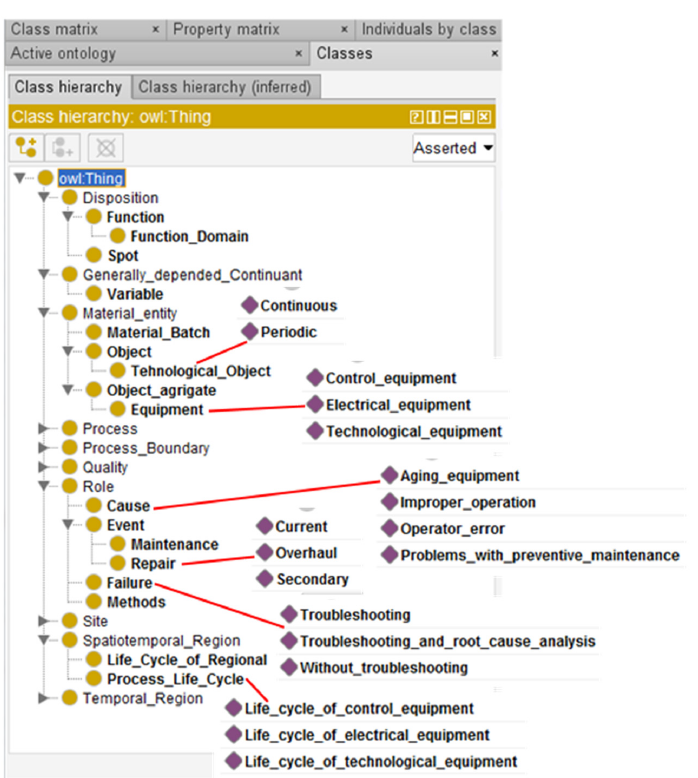
Figure 3. Core ontology class hierarchy and their instances in Protege.